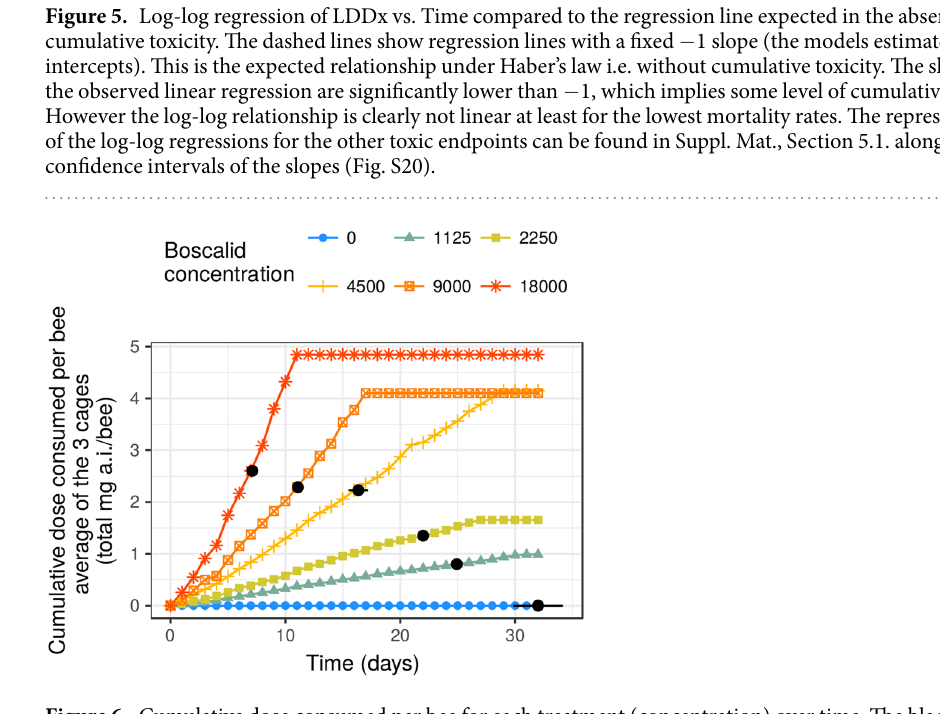
Figure 6. Cumulative dose consumed per bee for each treatment (concentration) over time. The black dots indicate the estimated values of LT 50 (with 95% confidence intervals) for each concentration. Without cumulative toxicity, the black dots should appear horizontally at approximately the same level of cumulative dose or aligned vertically above the control LT 50 for the two lowest